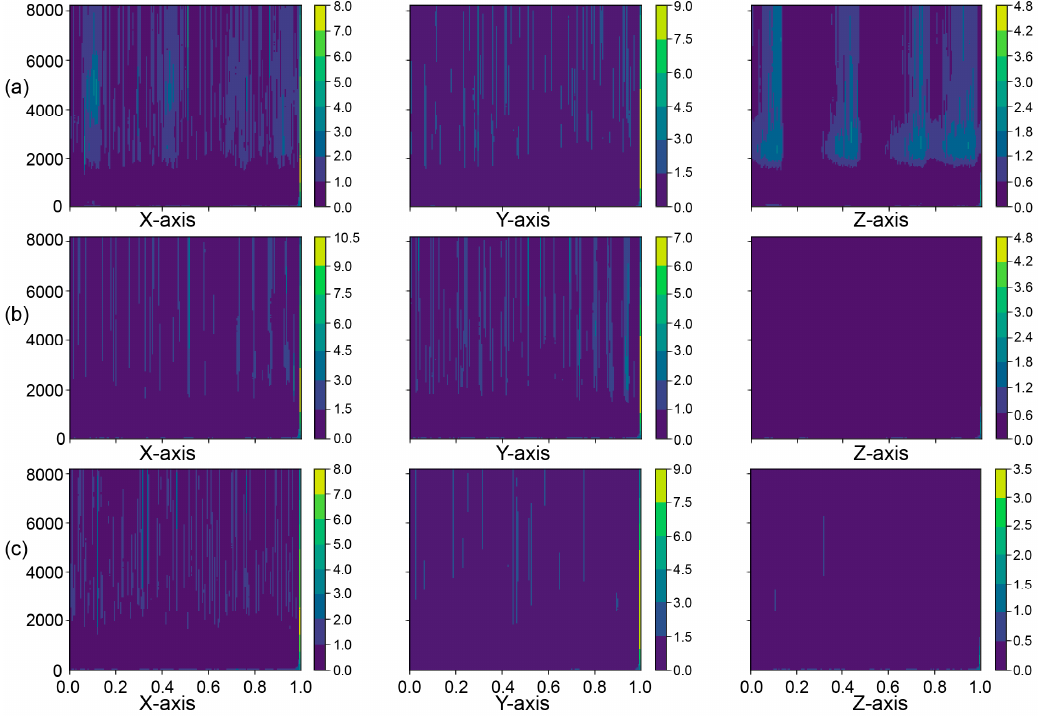
Figure 8. Time–frequency image after wavelet transform. ( a ) Fine Gravel Sandstone, ( b ) Fine Sandstone, ( c ) Mudstone.